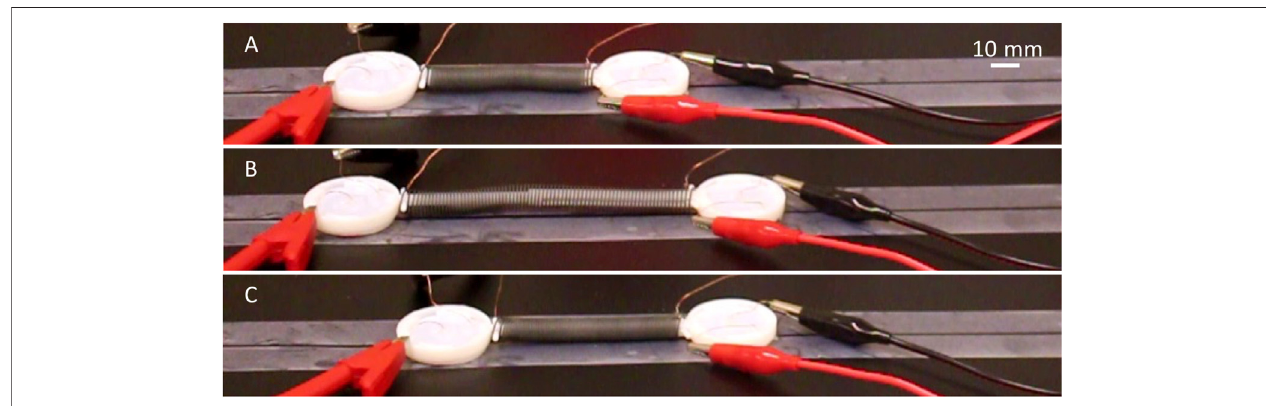
FIGURE 11 | Illustration of the earthworm inspired soft robot crawling forward. (A) Activating the rear pad. (B) By extending the nitinol spring, the front pad moves forward. (C) Deactivating the rear pad and activating the front pad followed by deactivation of the nitinol spring the rear pad slides forward during contraction of the